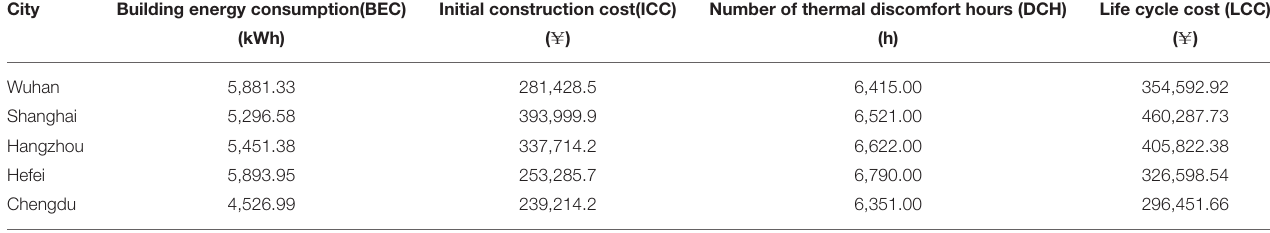
TABLE 6 | Summary of the simulation outcome for the selected cities. City